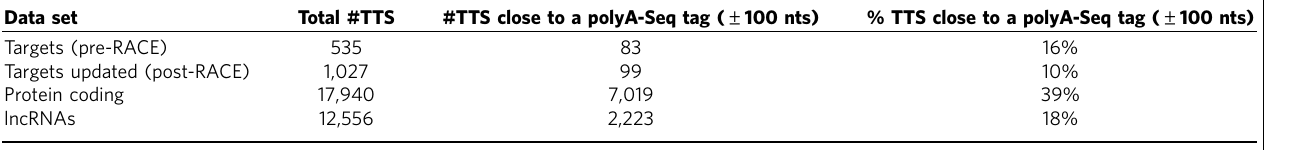
Table 1 | Comparison of various TTS data sets with Merck PolyA-Seq peaks. Data set